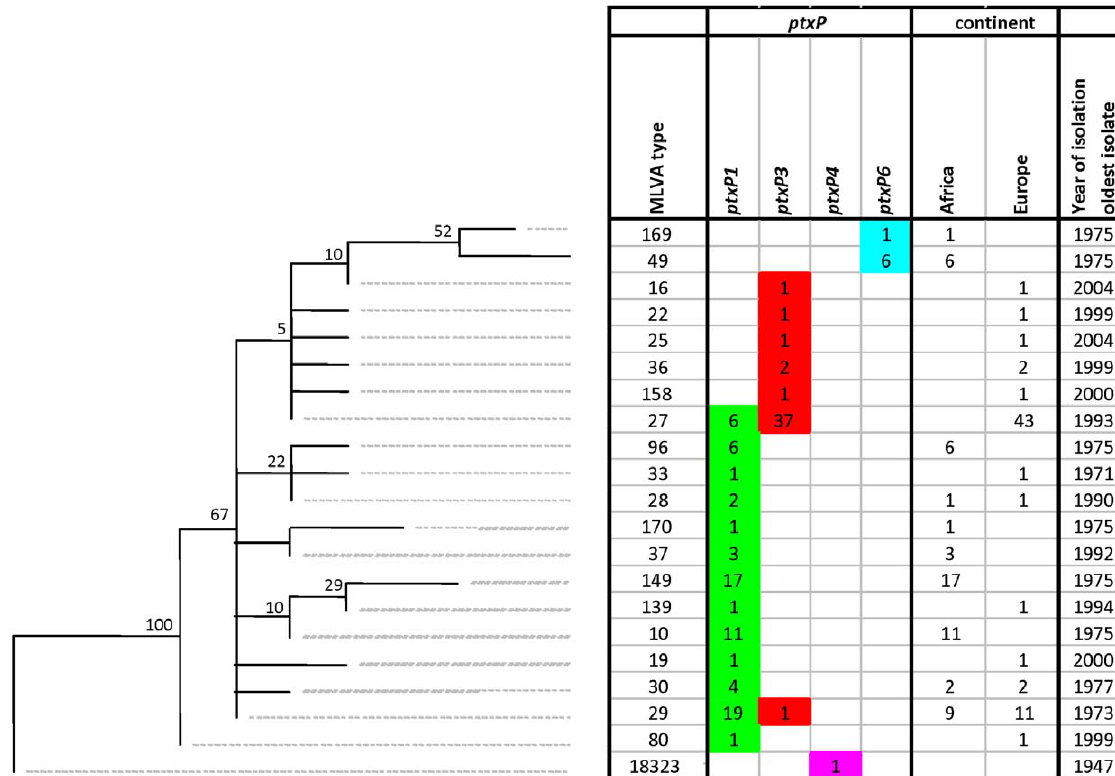
Figure 4. Maximum Parsimony tree of 125 B.pertussis isolates based on MLVA. See legends to Fig. 1 for further details.